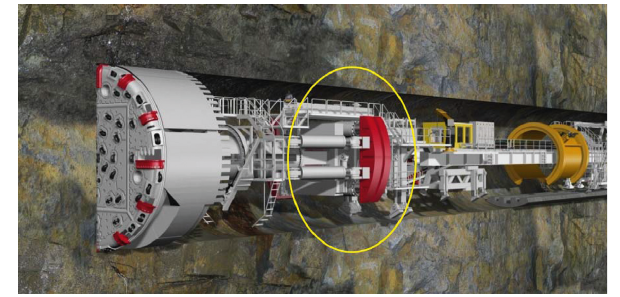
Figure 5: Gripper TBM used for the excavation of NJHP tunnel. Table 3: Main specifications of the Steg and Raron